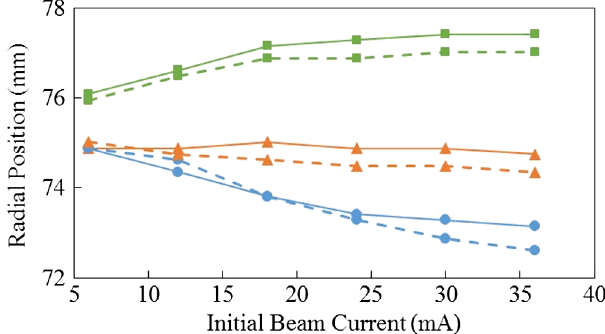
FIG. 11. Radial positions of the peak of each finger of the five- finger probe (cf. text). Blue (circles): Finger 2, orange (triangles): Finger 3, green (squares): Finger 4, solid: FFT, dashed: